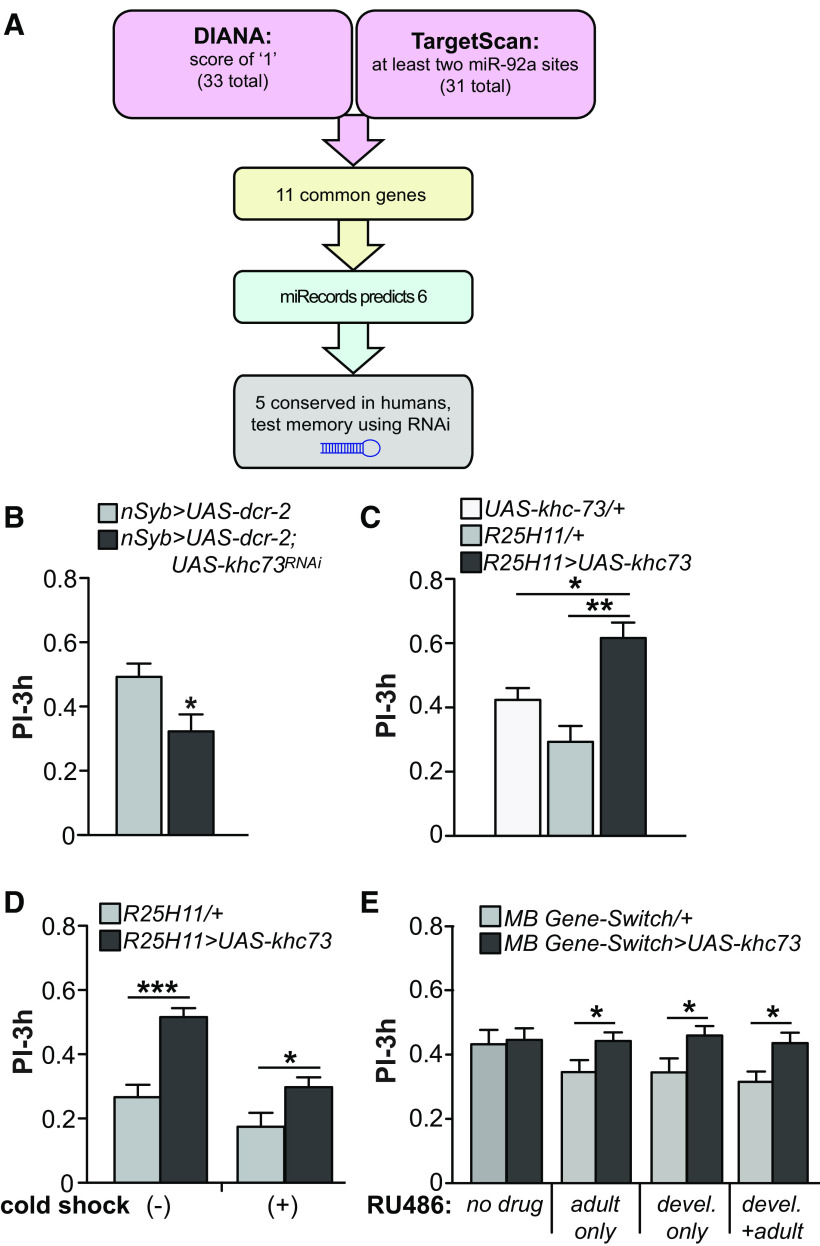
MiR-92a mRNA target prediction. A, Design of the mRNA target prediction pipeline. Top predictions for DIANA and TargetScan have 11 genes in common, six of which are also predicted by miRecords. Five of these potential mRNA targets have human homologs that are predicted targets for human miR-92a. B, khc73 RNAi expression produces memory impairment. Only khc73 of the five candidates (Table 1) significantly impaired 3-h memory using RNAi driven by pan-neuronal nSyb-GAL4. PIs are the mean ± SEM with n = 10. Two-tailed, two-sample Student’s t tests, *p < 0.05. C, UAS-khc73 overexpression enhances 3-h memory. Expression of UAS-khc73 driven by R25H11-GAL4 significantly enhanced 3-h memory compared with UAS-only and GAL4-only controls. PIs are the mean ± SEM with n = 10. One-way ANOVA followed by Bonferroni’s post hoc tests, *p < 0.05, **p < 0.01. D, Overexpressing khc73 using R25H11-GAL4 enhances ARM. Flies were subjected to cold shock 2-h after aversive conditioning and memory was tested at 3-h. Consistent with miR-92a inhibition, overexpressing khc73 enhances ARM. PIs are the mean ± SEM with n = 12. Two-tailed, two-sample Student’s t tests, *p < 0.05, ***p < 0.001. E, Overexpressing khc73 during development (devel), adulthood (adult), or both (devel + adult) enhances adult memory as assayed using the Gene-Switch system. Administration of RU486 increases mushroom body expression of khc73 controlled by the MB-Gene-Switch driver. Similar to the effect observed in Figure 2D, RU treatment either during development or adulthood alters the PIs of the control genotype. PIs are the mean ± SEM with n = 16–20. Two-tailed, two-sample Student’s t tests for each RU486 feeding condition, *p < 0.05.